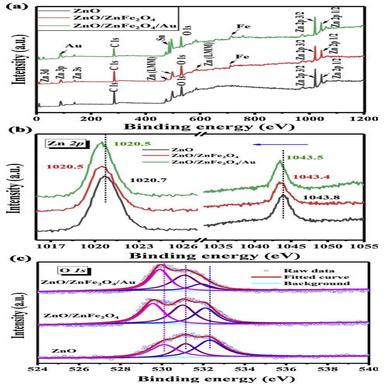
(a) XPS survey spectra of ZnO hollow nanomeshes, ZnO/ZnFe2O4 and ZnO/ZnFe2O4/Au composites; (b) high-resolution XPS spectra of Zn 2p; and (c) high-resolution O 1s and fitted XPS peaks.